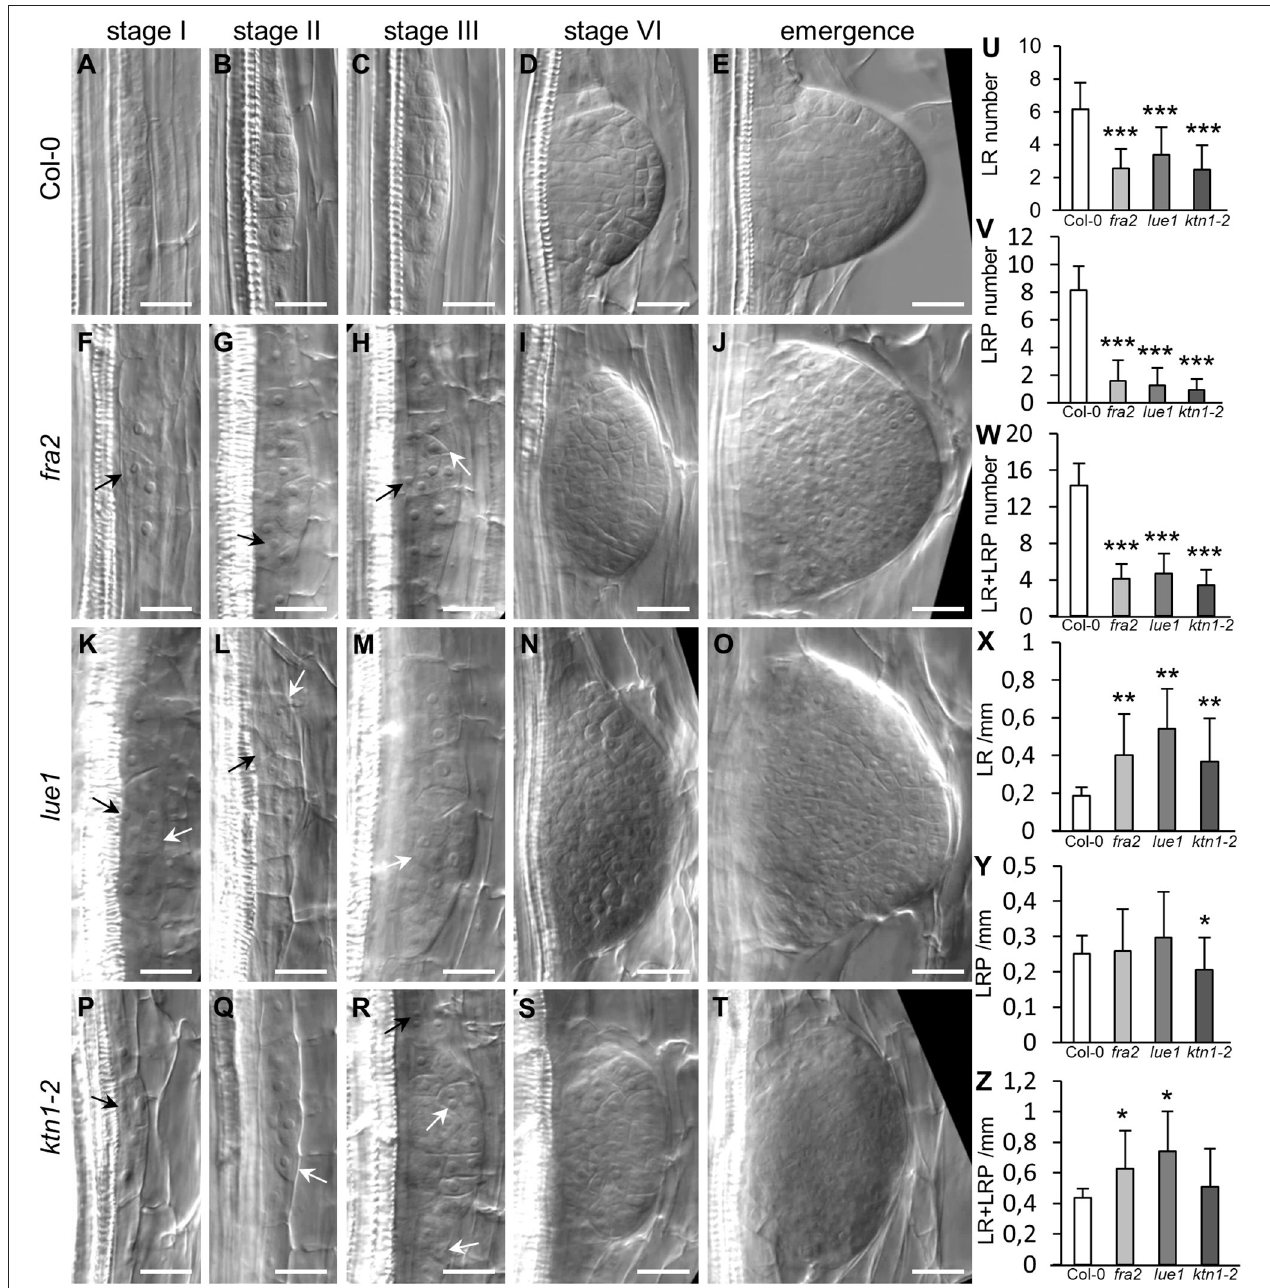
FIGURE 6 | Phenotypes of lateral root primordia in Col-0 and katanin1 mutants. (A–T) Representative pictures of selected developmental stages of lateral root primordia in 7 days old seedlings of Col-0 (A–E) , fra2 (F–J) , lue1 (K–O) , and ktn1-2 (P–T) mutants. Ectopic positions of cells in early stages of lateral root primordia development are indicated by arrows. Stages of lateral root primordia development were annotated according to Malamy and Benfey (1997). (U–Z) Quantitative analysis ( ± SD) of lateral root phenotype in 7 days old seedlings of Col-0 and katanin1 mutants. Number of lateral roots (LR) per plant (U) , number of lateral root primordia (LRP) per plant (V) , number of lateral roots, and lateral root primordia (LR + LRP) per plant (W) , density of lateral roots (LR/mm; X ), density of lateral root primordia (LRP/mm; Y ), density of lateral roots, and lateral root primordia (LR + LRP/mm; Z ). Calculations are based on data collection from 13–19 seedlings. Asterisks indicate statistical significance between measurements (* p < 0.05, ** p < 0.01, and *** p < 0.001). Bar: (A–T) 20 µ m. followed by successive anticlinal and periclinal divisions published (Malamy and Benfey, 1997). Whereas, it was possible to identify asymmetric anticlinal divisions in the pericycle during the establishment of LRP in Col-0 roots (Stage I; Figure 6A ),